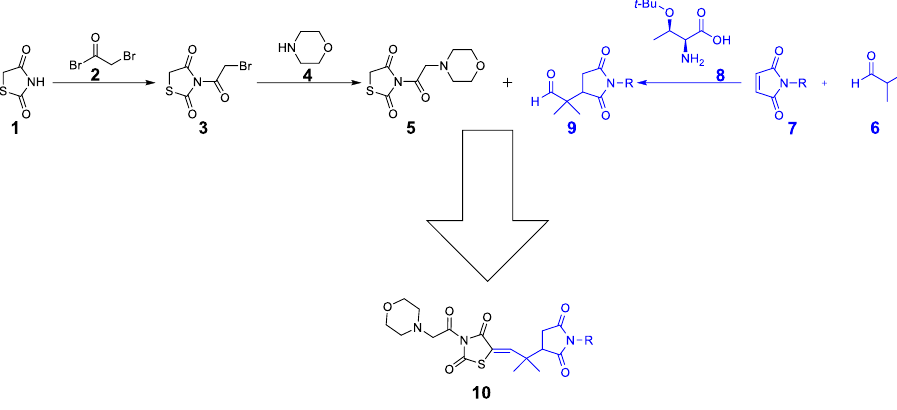
Scheme 1. Synthetic approach to final compound 10